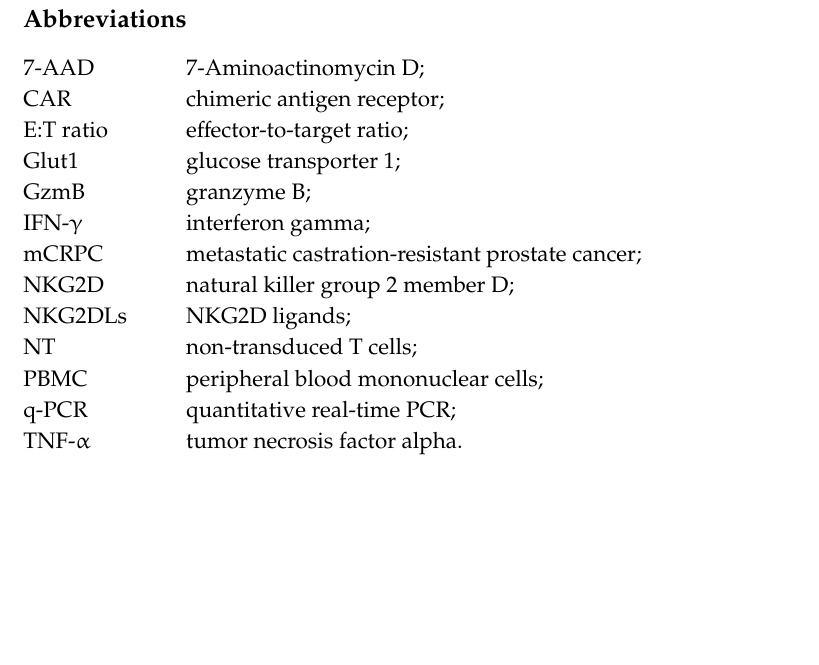
Figure S1: Expression level of NKG2D ligands. Q-PCR (a) and flow cytometry analysis (b) of the expression of NKG2D ligands on prostate cancer cell lines of PC-3, DU 145 and C4-2. The same cells stained with isotype antibody were used for gating (black). Data shown are representatives of experiments with similar results, Figure S2: Expression level of NKG2D CAR. Human T cells were transduced with lentiviruses expressing NKG2D-CAR or NKG2DIL7-CAR and the representative flow cytometry plot was indicated. Gating was based on the same cells stained with isotype-matched antibody. Data shown are representatives of experiments with similar